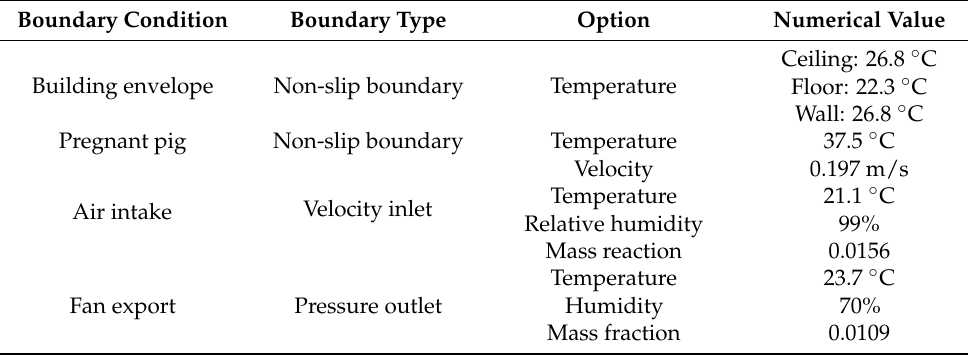
Table 2. Boundary condition settings.